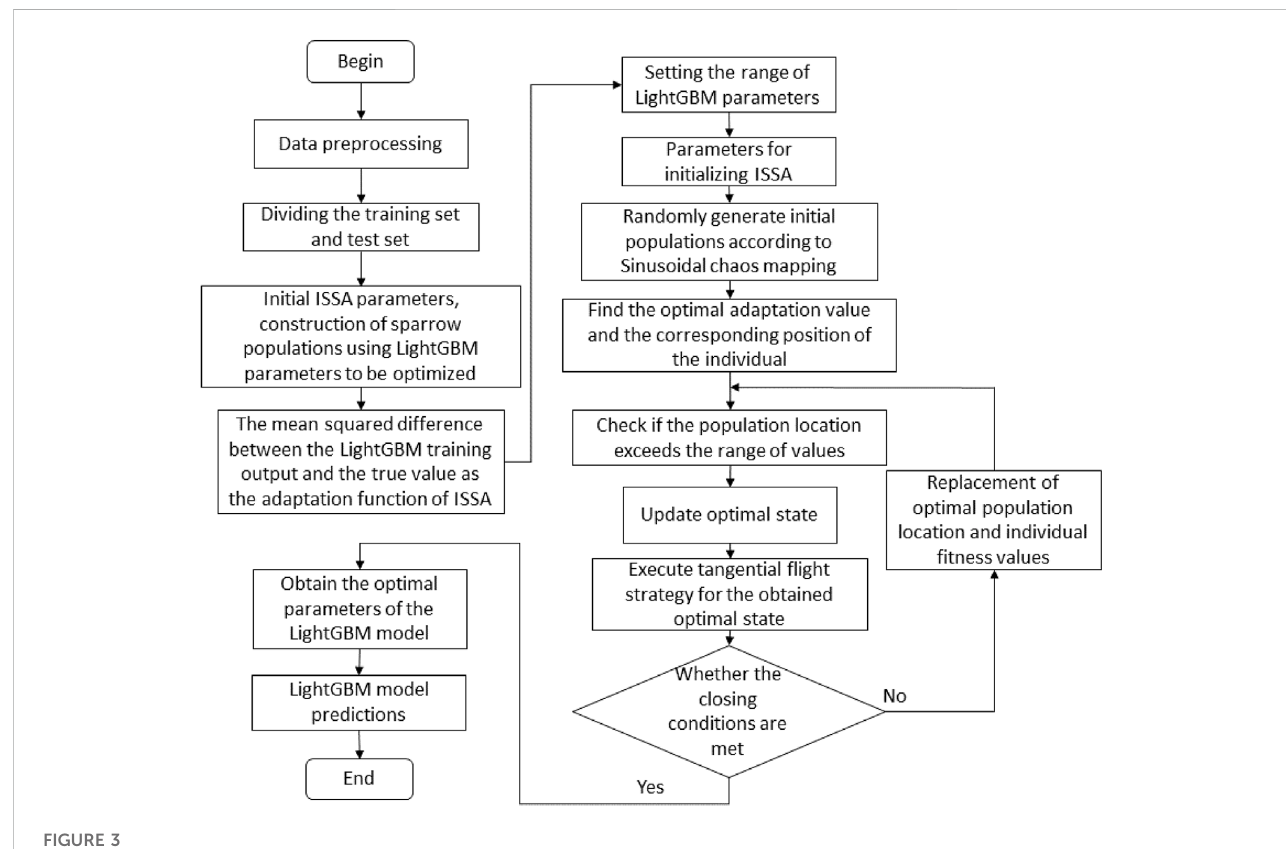
FIGURE 3 ISSA-LightGBM algorithm